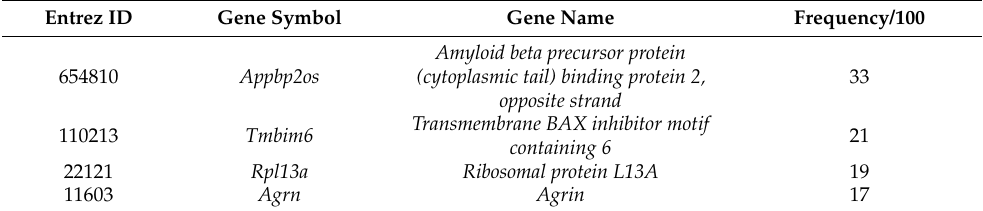
Figure 2. Feature frequencies, obtained by 100 runs of iterative feature selection procedure, for ( A ) simple scaled dataset, ( B ) dataset without correlated genes and, ( C ) dataset without co-expressed genes. There are 4 features for the simple scaled dataset, 6 features for the dataset without correlated genes, and 7 features for dataset without co-expressed genes, which have noticeably higher frequencies than other features. Table 4. The most frequent genes within 100 runs of the iterative feature selection procedure on the simple scaled dataset.